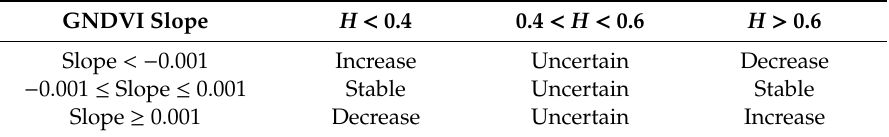
Table 1. Classification of the GNDVIvariation in the